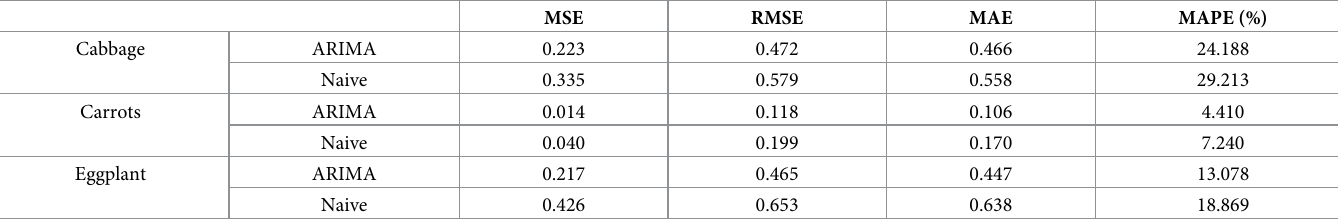
Table 1. Effectiveness of average vegetable price